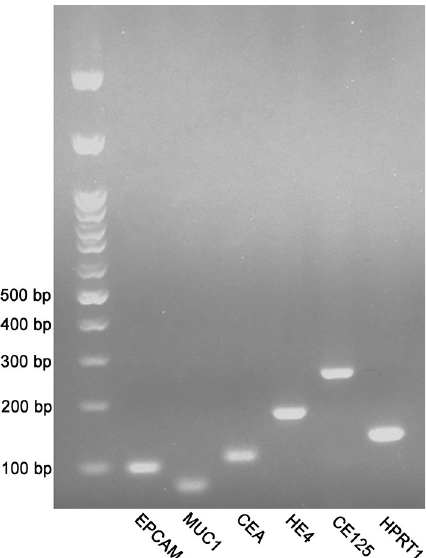
Figure 1. Gel electrophoresis image (agarose 2%) of the amplification products obtained for our target genes. From the left, lane 1: molecular weight marker (100-pb DNA ladder); lanes 2–7: EPCAM (99 bp), MUC1 (71 bp), CEA (108 bp), HE4 (173 bp), CA125 (248 bp) and HPRT1 (131